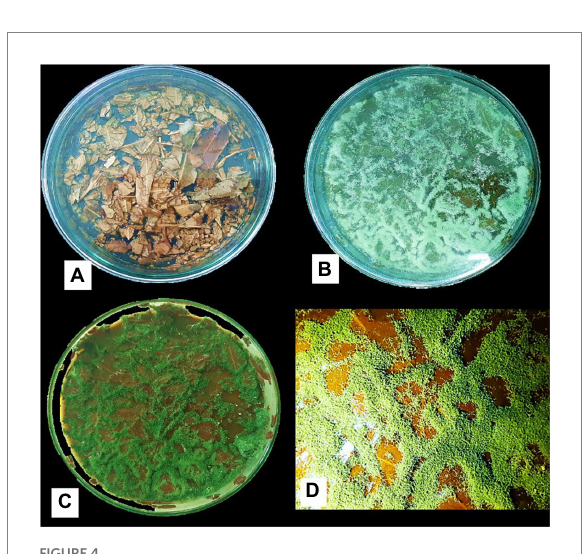
FIGURE 4 Growth of Trichoderma isolate (TI04) on Eucalyptus leaves (A) Before inoculation with spore suspension (B) Growth after 6 days of inoculation (C) Growth after 15 days of inoculation (D) Scattered spore mat on degraded Eucalyptus